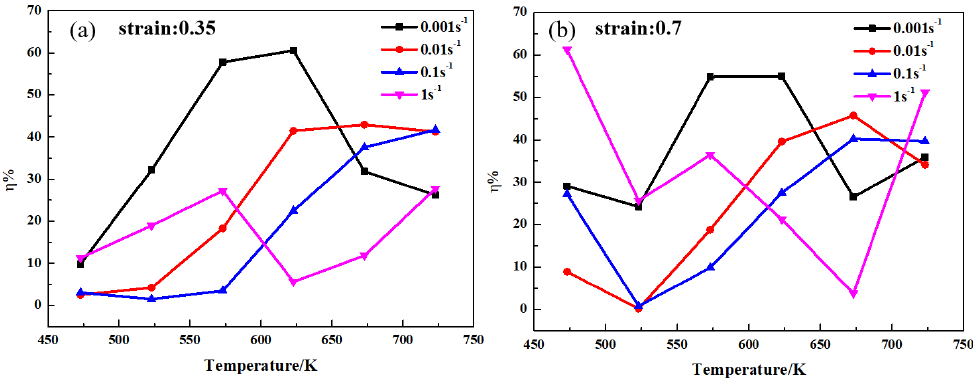
Figure 5. Relationship between the power dissipation value ( η%) and the deformation temperature under different strains: ( a ) 0.35; ( b ) 0.7.